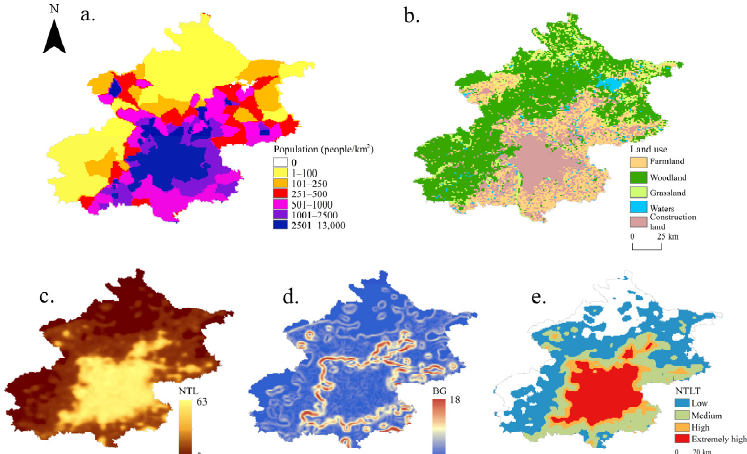
Figure 5. Comparison and verification diagrams of different data types in Beijing, 2020: ( a ) Population data; ( b ) land use data; ( c ) nighttime lights; ( d ) brightness gradients; ( e ) the types of PANDA.